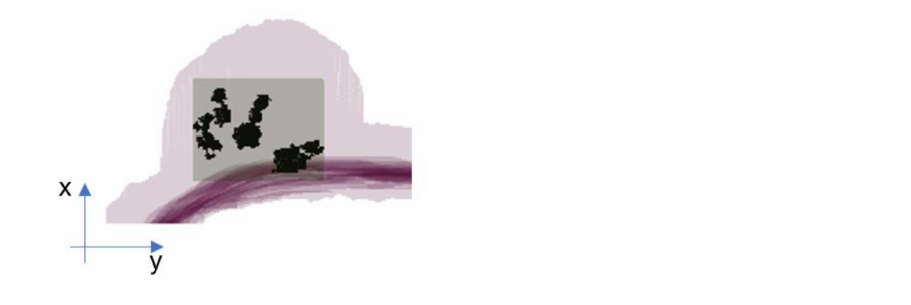
Figure 1. Representation of the SVB option, only the smallest 3D bounding box confined to the tumor region is considered.